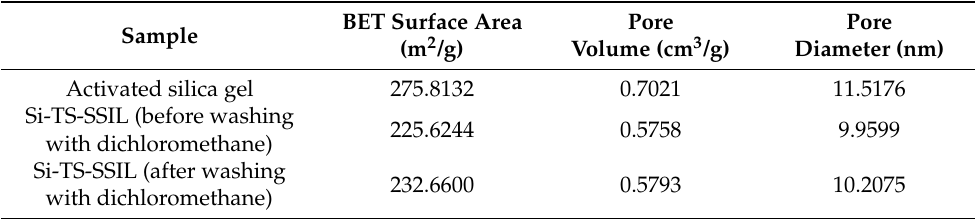
Table 2. The results of BET analyses for activated silica gel and Si-TS-SSIL (before and after washing with